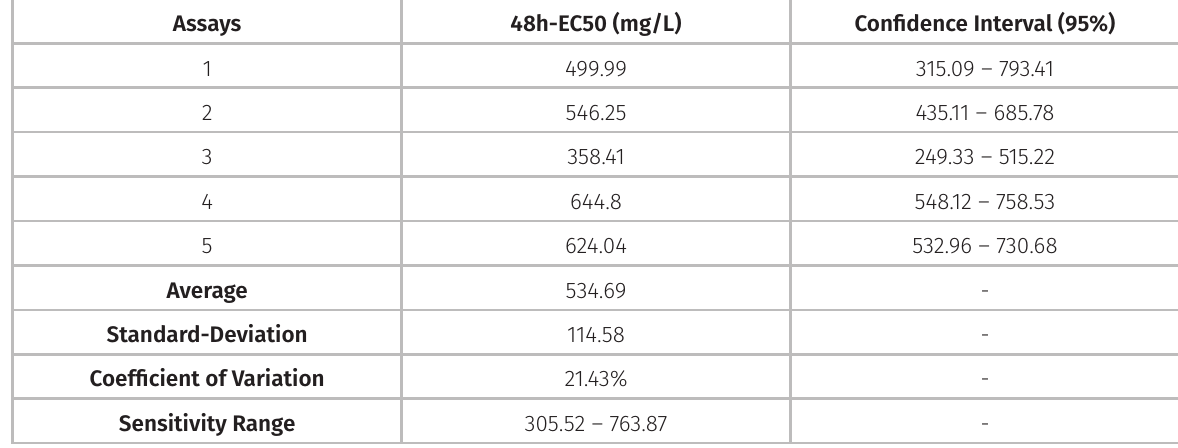
Table III. 48h-EC50 values for D. similis obtained in the tests with the herbicide Siptran 500SC®. Assays